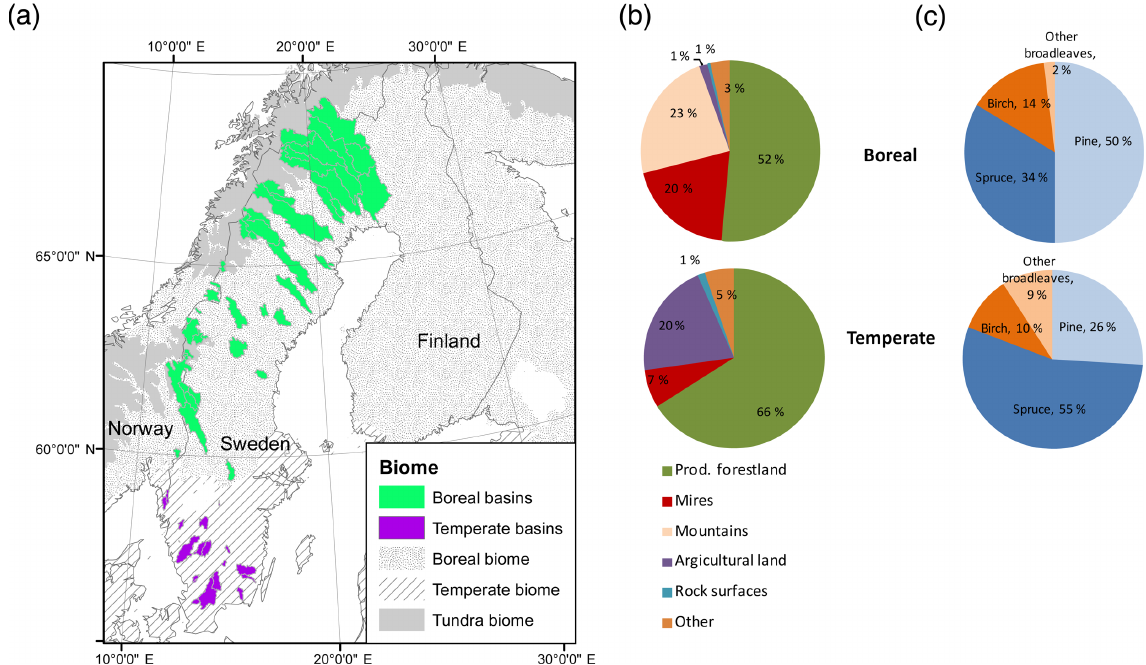
Figure 1. Location, land cover and forest change in the 65 basins used in this study. (a) The location of boreal (green) and temperate (purple) basins, (b) land cover in each basin group in terms of relative area and (c) composition of the forest by coniferous (blue) and deciduous (orange)